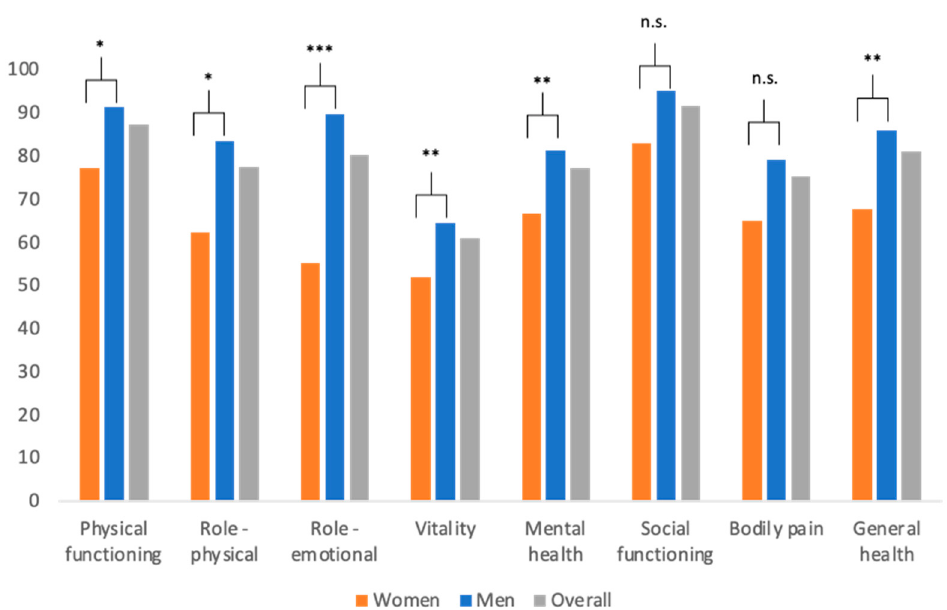
Figure 1. SF-36 domains and general health divided by gender and overall. Mean values ± standard deviation for each domain, given for women/men/overall ( p -value): physical functioning 77.3 ± 29.0/91.2 ± 16.3/87.3 ± 21.4 ( p = 0.010). Role—physical 62.1 ± 47.5/83.3 ± 35.1/77.5 ± 40.0 ( p = 0.020). Role—emotional 55.2 ± 49.8/89.6 ± 30.3/80.2 ± 40.0 ( p < 0.001). Vitality 51.9 ± 21.0/64.3 ± 18.1/80.9 ± 19.7 ( p = 0.003). Mental health 66.6 ± 21.9/81.3 ± 13.7/77.3 ± 17.5 ( p = 0.001). Social functioning 82.9 ± 33.9/95.0 ± 17.9/91.7 ± 23.9 ( p = 0.050). Bodily pain 64.8 ± 40.3/79.2 ± 30.3/75.2 ± 33.8 ( p = 0.061). General health 67.6 ± 29.8/86.0 ± 20.8/81.0 ± 24.9 ( p = 0.002). n.s. = not significant, * p < 0.05, ** p < 0.01, *** p < 0.001 .